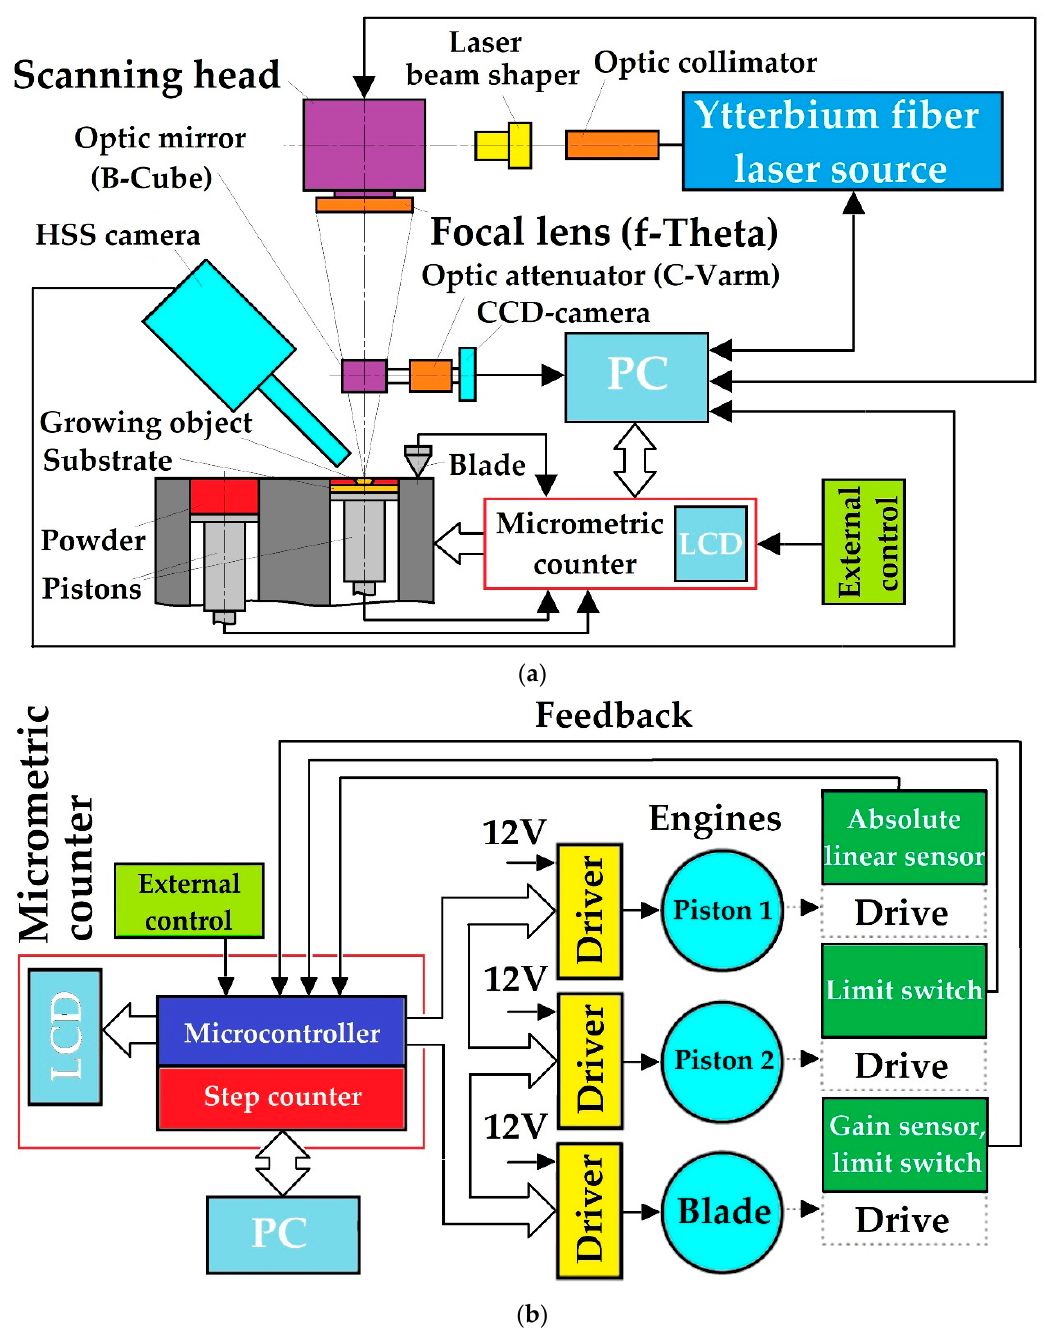
Figure 6. The principal scheme of the experimental setup: ( a ) optical and ( b ) mechanical parts.